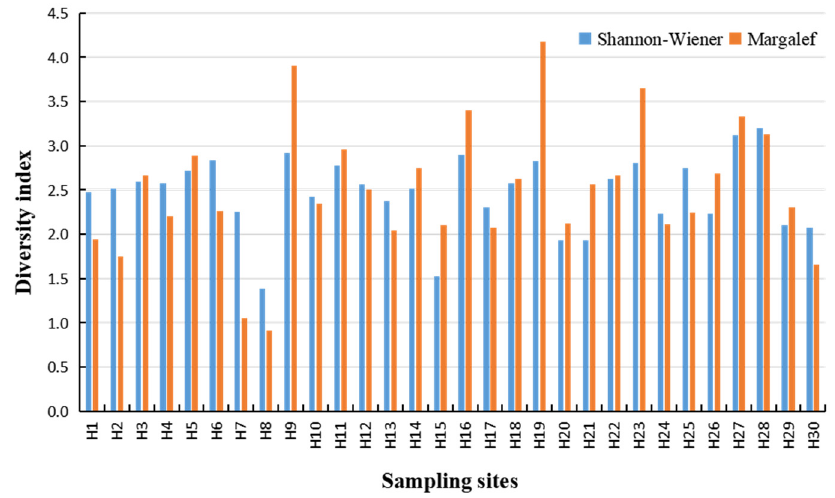
Figure 7. Phytoplankton biodiversity index in the Huaihe River Basin.